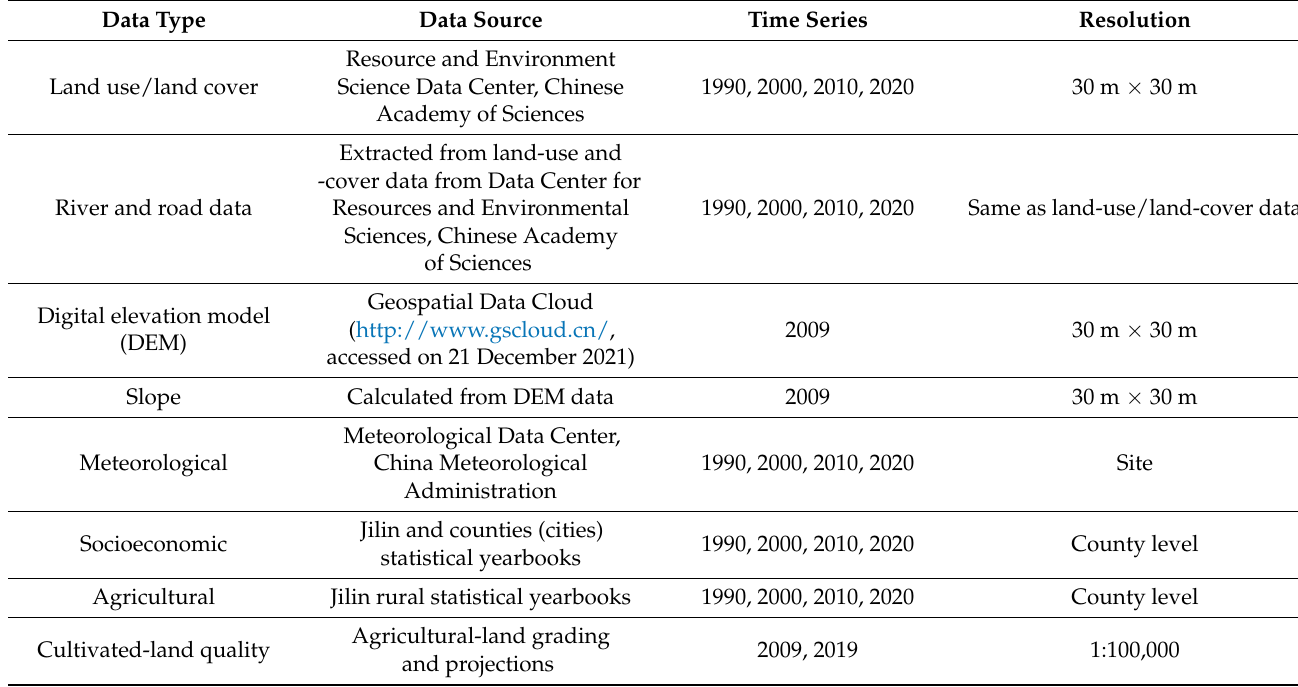
Table 1. Descriptions of the data sources.